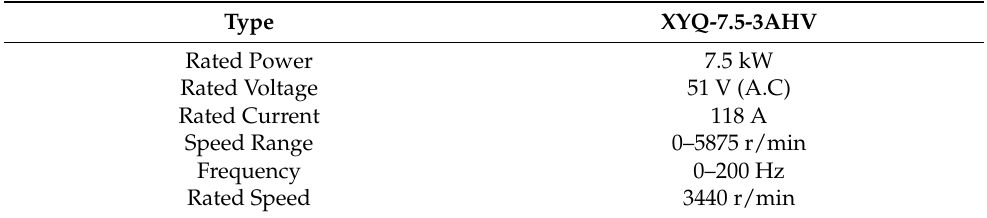
Table 3. Electric motor